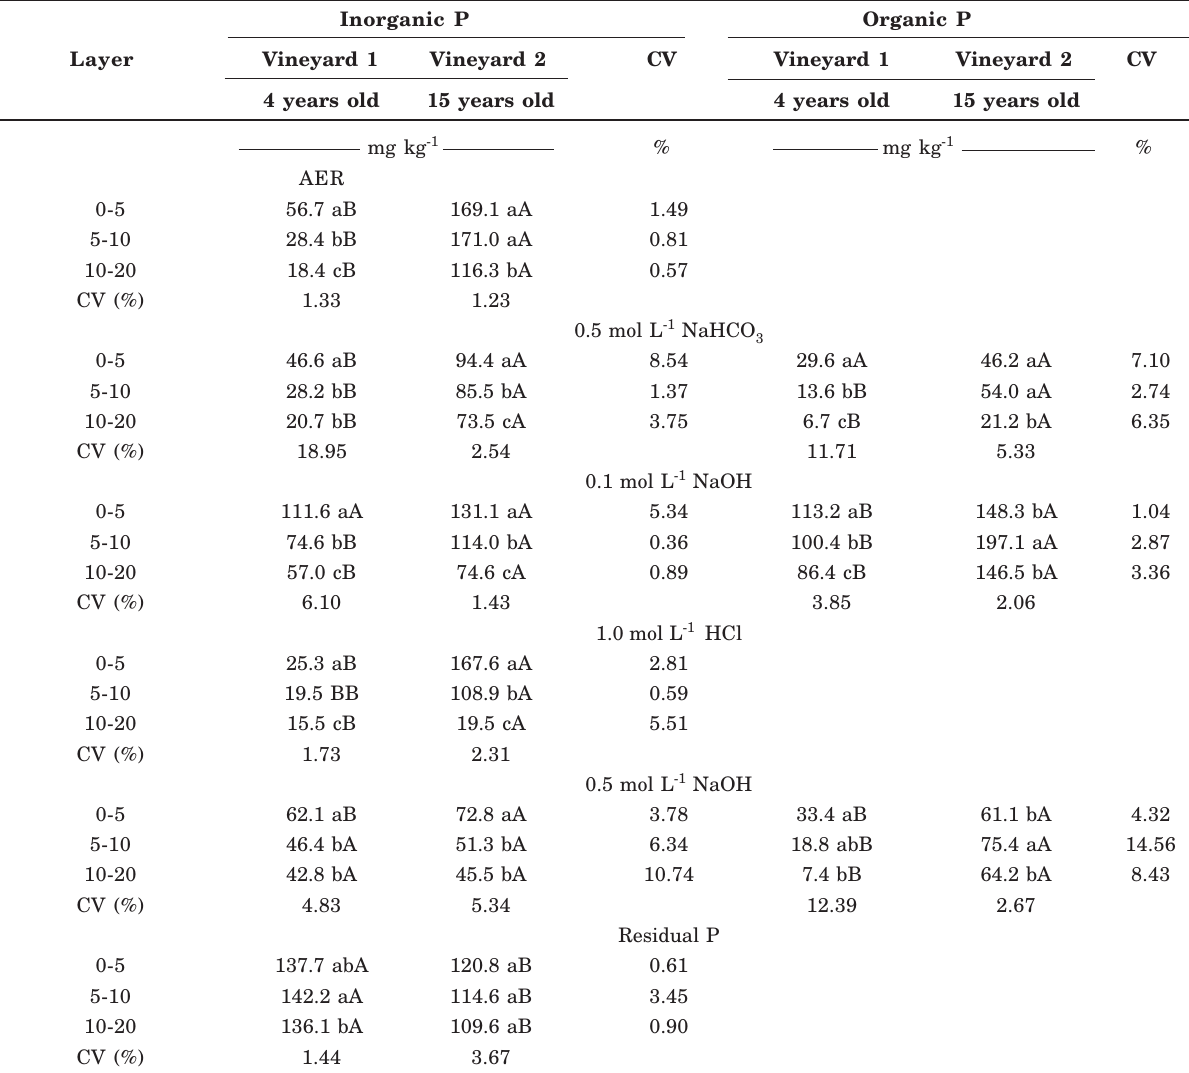
Table 2. Phosphorus inorganic and organic fractions extracted by: anion exchange resin (AER); 0.5 mol L